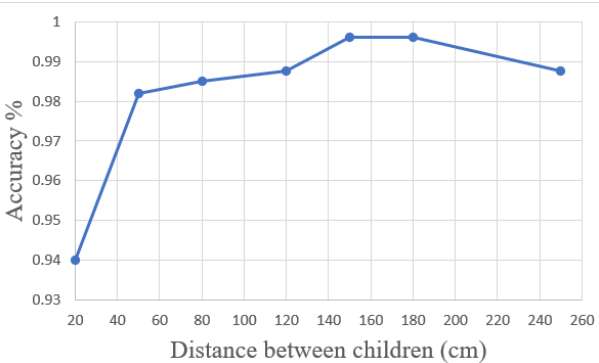
Figure 4. The relationship between the distance between children and the accuracy of the system.